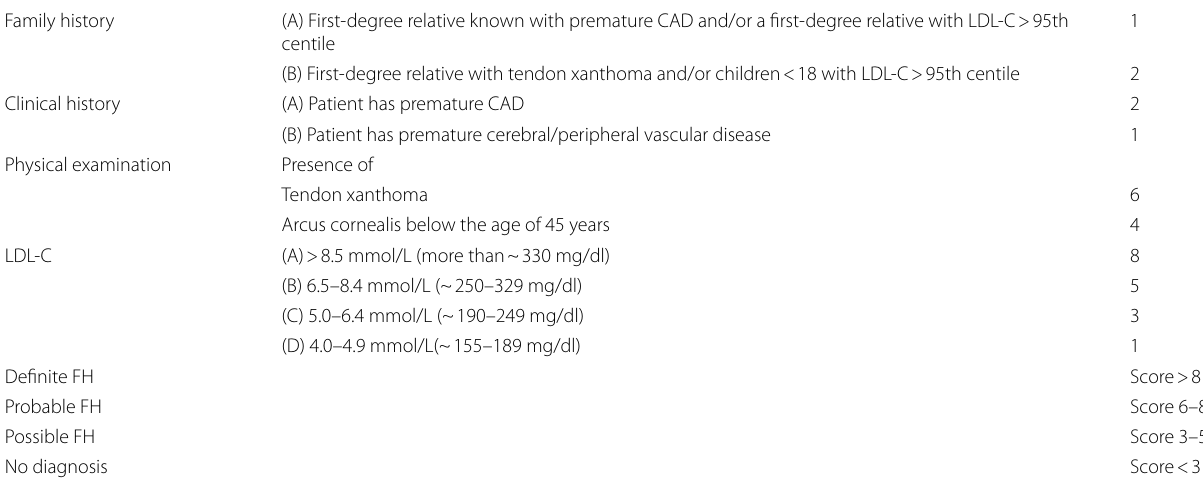
Table 1 The Dutch Lipid Clinic Network